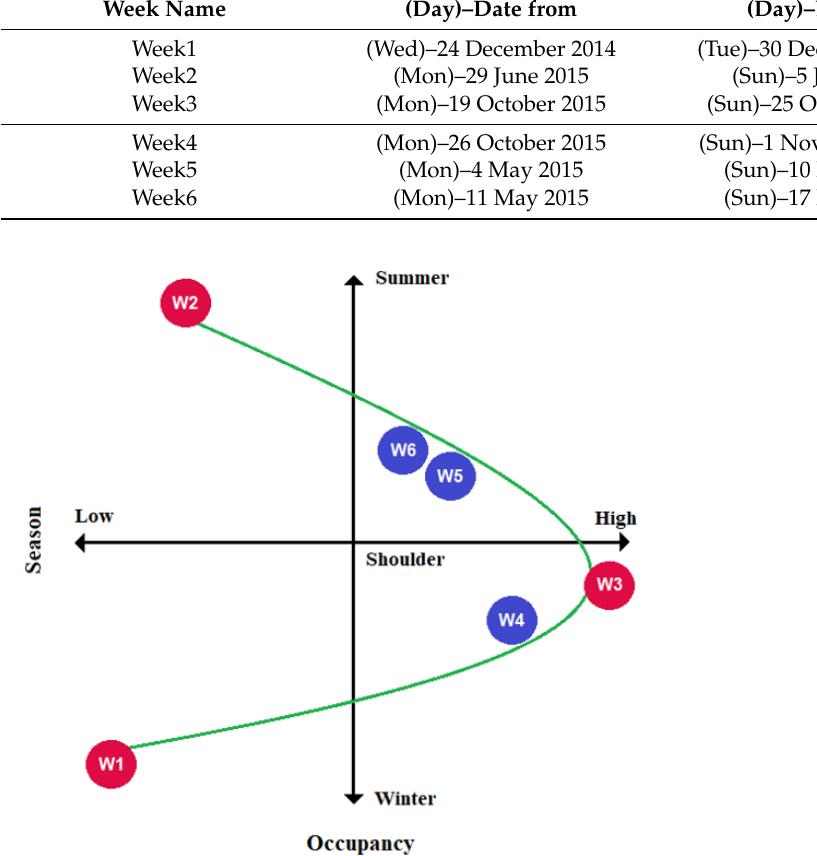
Figure 3. Plot of seasons and occupancy levels considered for calibration in red and validation in blue (Points are illustrative and are representative of typical patterns of occupancy in the case study building).